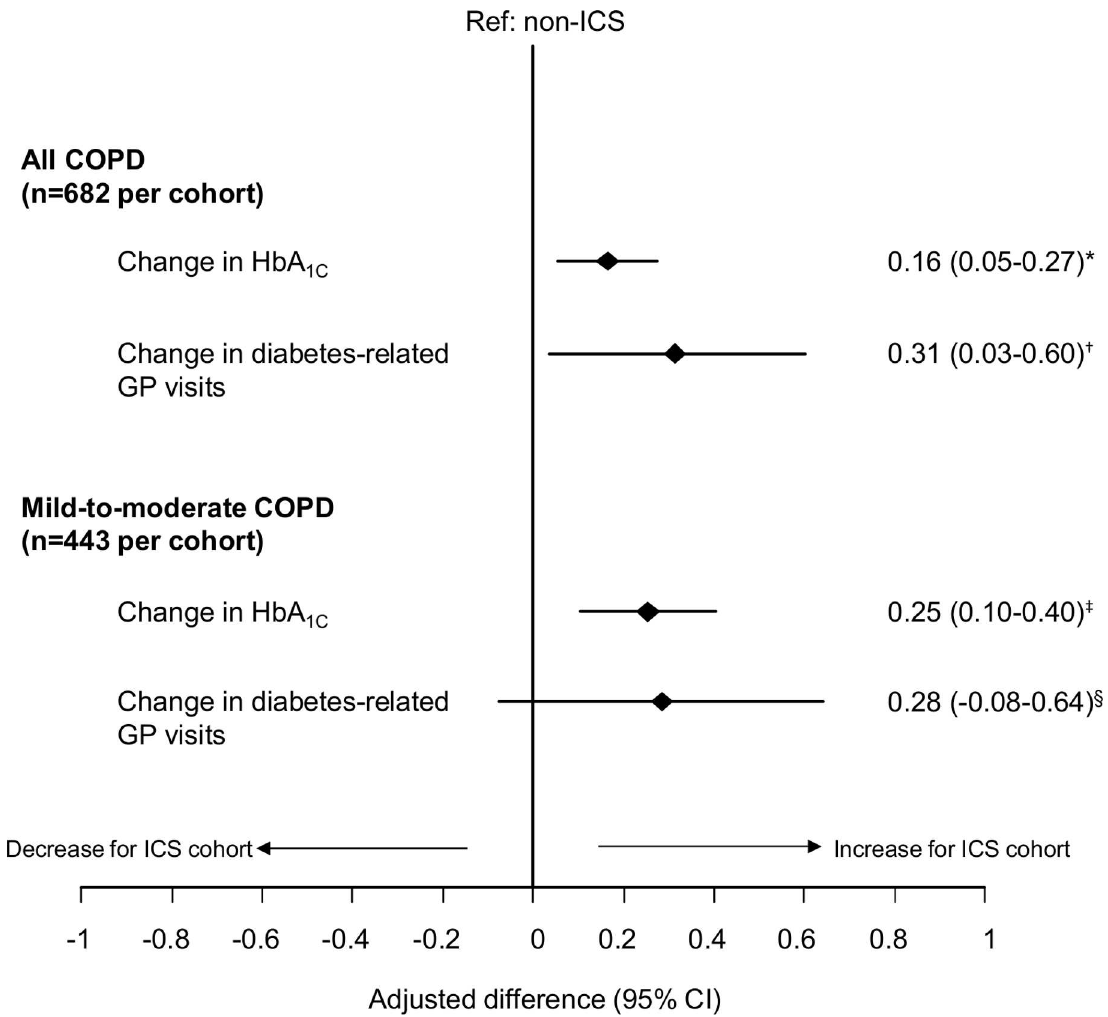
Fig 1. Comparison of changes in HbA 1C and diabetes-related GP visits between ICS and non-ICS cohorts. Mild-to- moderate COPD patients identifiedby GOLD groups A and B. * Adjusted for number of acute courses of OCS and diagnosisof pneumonia during baseline,time between baselineand outcome HbA 1c readings,and acute OCS use between index date and outcome HbA 1c readings. † Adjusted for diagnosisof GORD in baseline,baselineHbA 1c , and duration of diabetes. ‡ Adjusted for number of acute OCS courses during baselineand time between baselineand outcome HbA 1c readings. § Adjusted for baseline HbA 1c and duration of diabetes.CI = confidence interval; COPD = chronic obstructive pulmonarydisease; HbA 1c = glycated haemoglobin; ICS = inhaledcorticosteroids; GORD = gastro-oesophagealreflux disease; GOLD = Global Initiative for Chronic Obstructive Lung Disease; GP = generalpractice; OCS = oral corticosteroids.